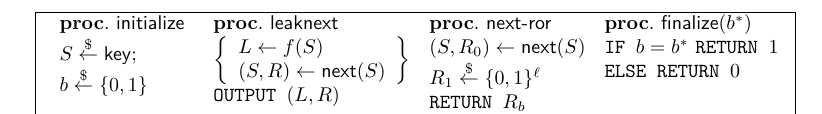
Figure 6: Procedures in Security Game LPR ( f )